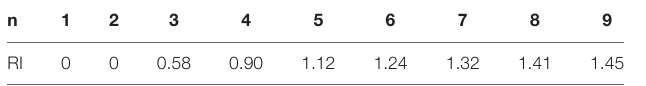
TABLE 2 | Randomized indicators.